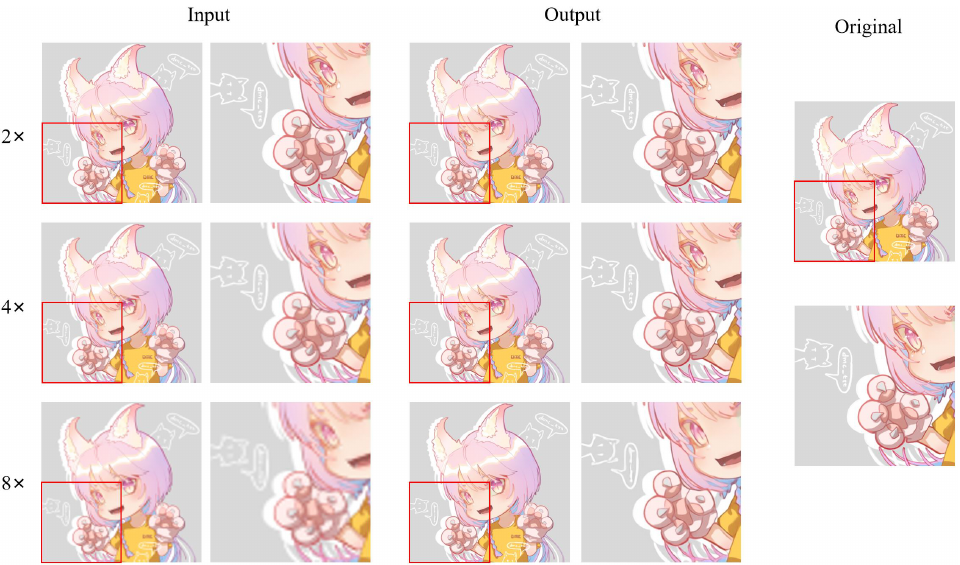
Figure 20. An example of visual result of an anime face on test dataset (AnimeFace180). To show the details of the generated anime image, we zoomed in on the anime face. The red box area is the area we intercepted and enlarged—visual result on the anime face.